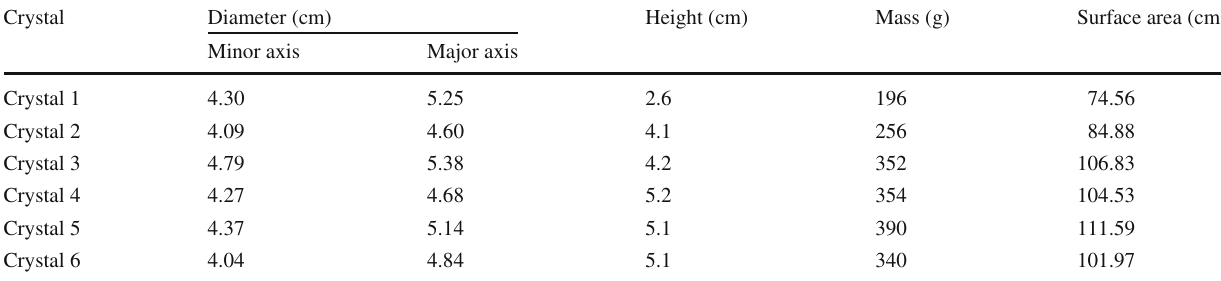
Table 1 CMO crystal scintillator sizes, masses, and surface areas